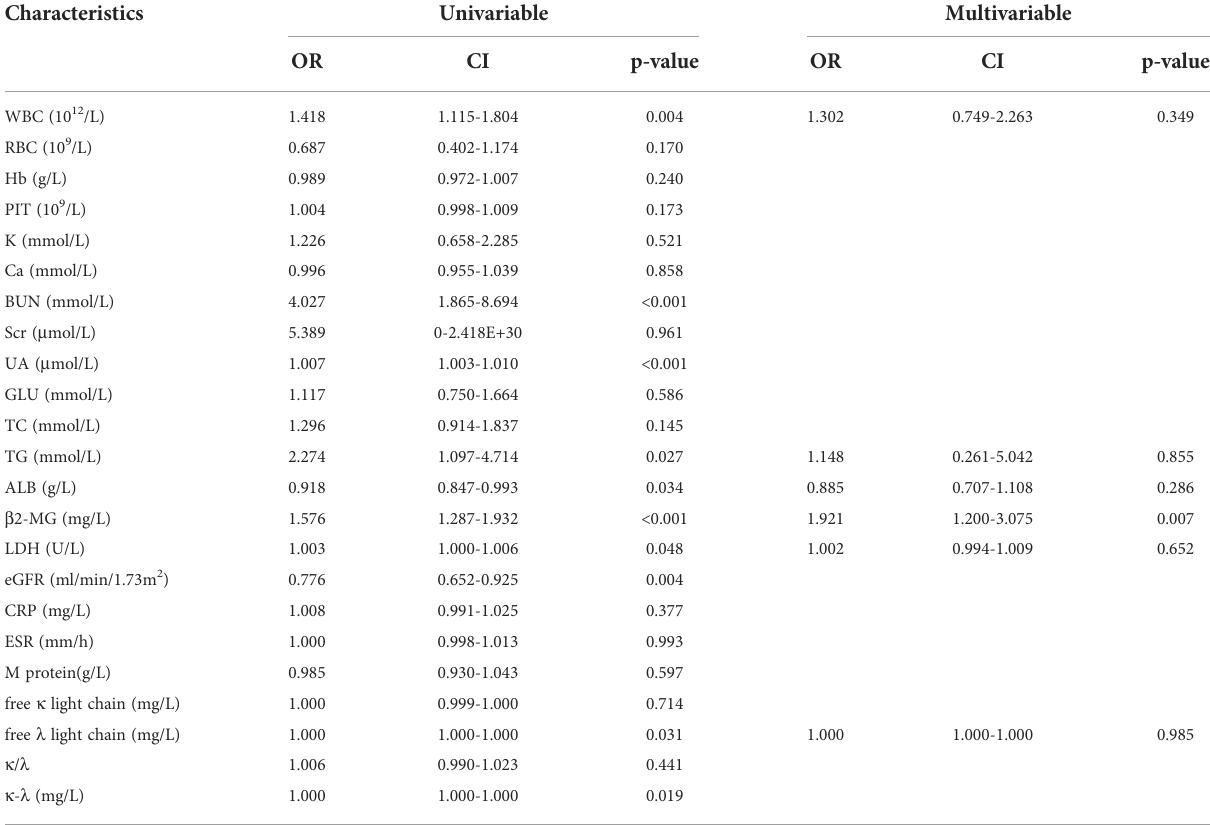
TABLE 2 Potential risk factors identi fi ed by univariate and multivariate logistic regression analyses.